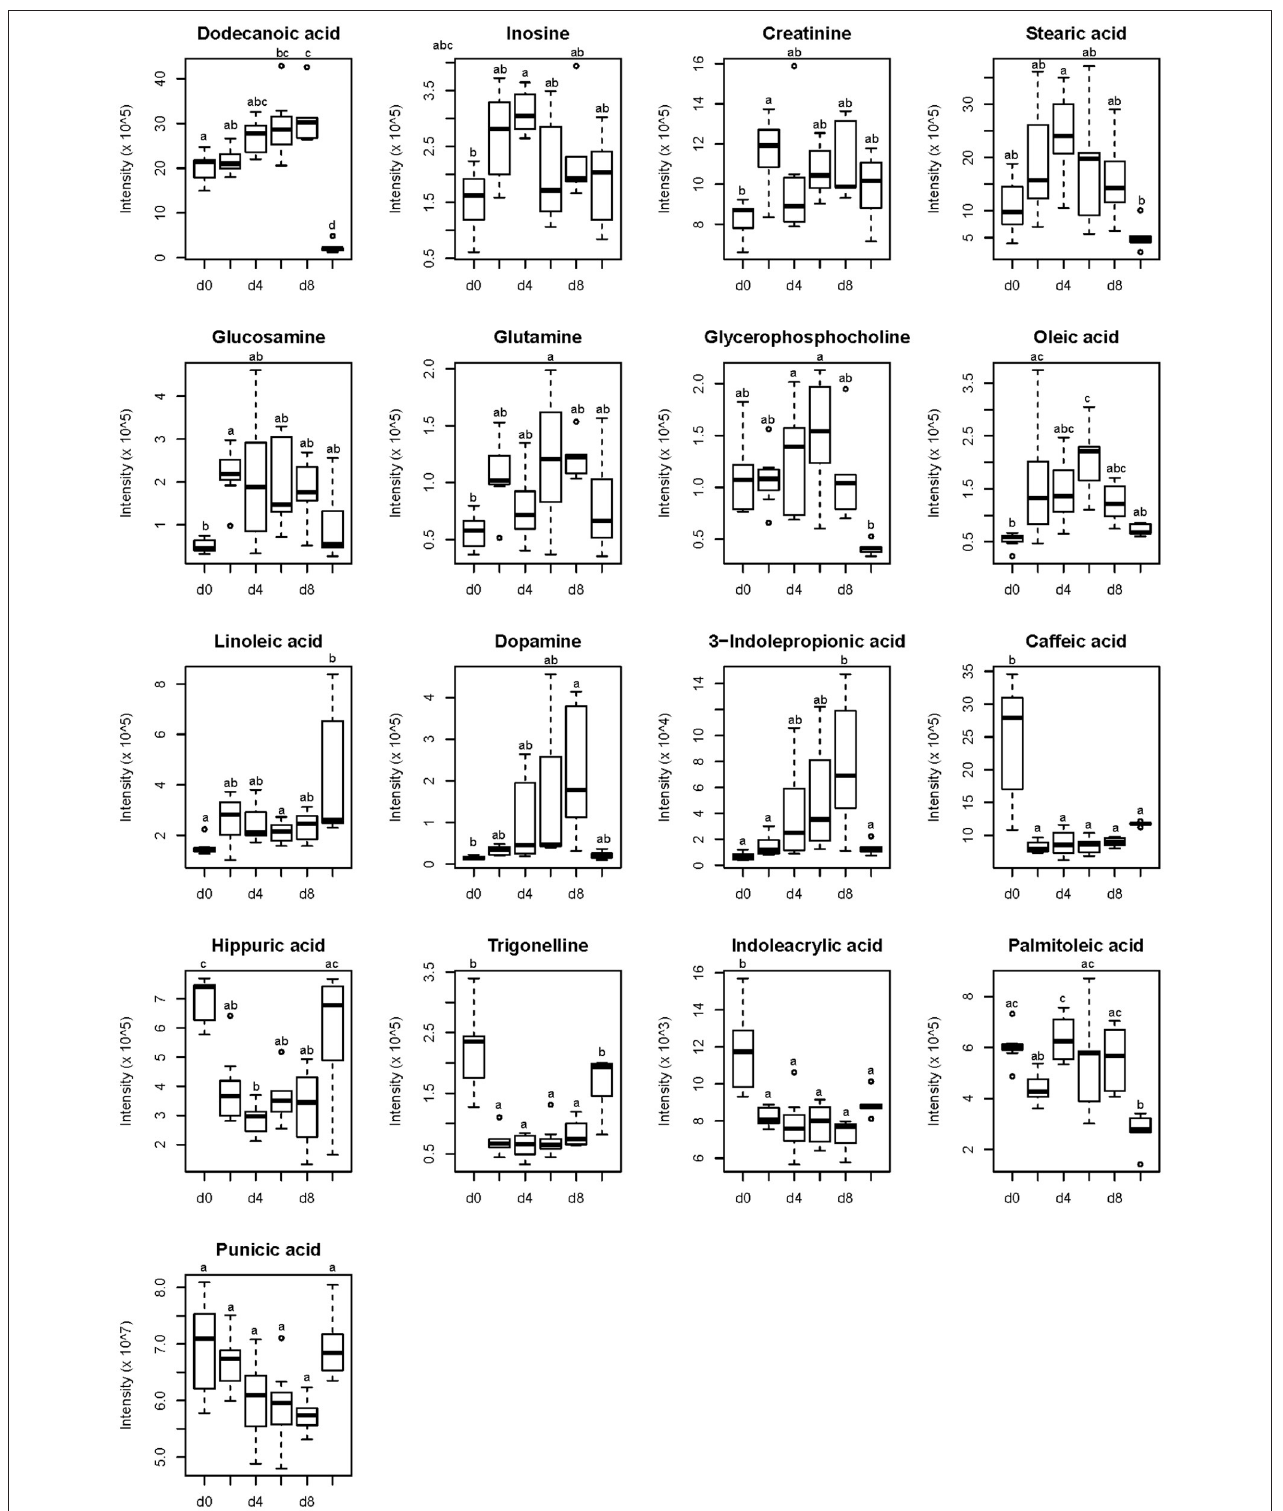
FIGURE 2 | Identified compounds of growing pigs changed during feeding level at metabolizable energy for maintenance. Relative concentrations of identified compounds are presented on the y-axis. Time points of sampling are presented on the x-axis and are defined as follows: d 0, d 2, d 4, d 6, and d 8 represented 0th, 2th, 4th, 6th and 8th day of feeding level at metabolizable energy for maintenance; d 9, refeeding at 2,400 kJ ME/kg BW 0.6 · d − 1 on d 9. a,b,c represents significant difference, p <